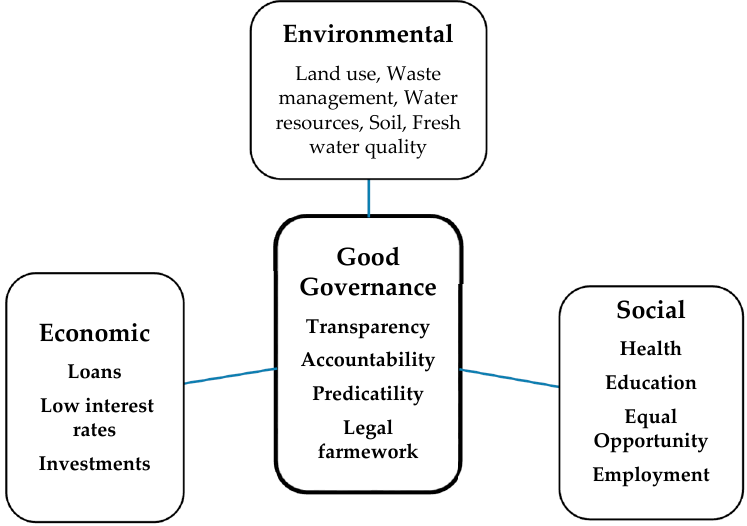
Figure 1. The Conceptual Framework: Sustainability. Source: Adapted from several sources, e.g. [33].